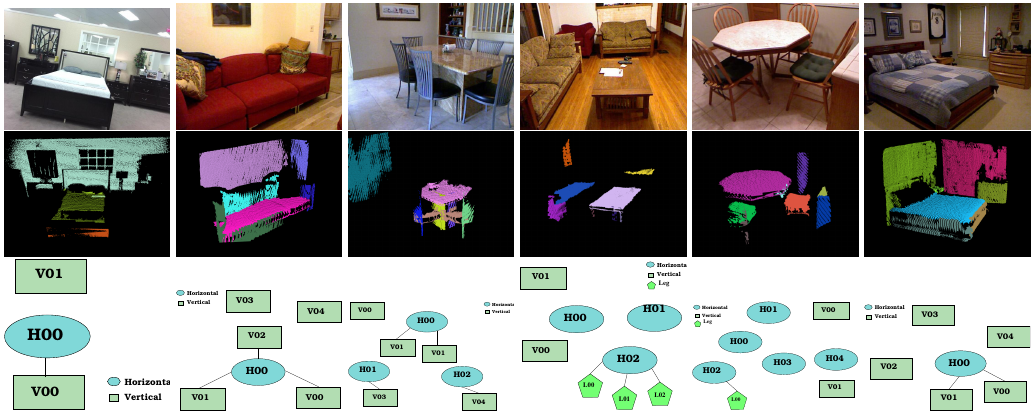
Figure 16. Graph comparison: in ( a ), one of the graphs generated from the scene in Figure 14b, and in ( b – d ), partial graphs selected for matching corresponding to the chair, the center table and the couch.